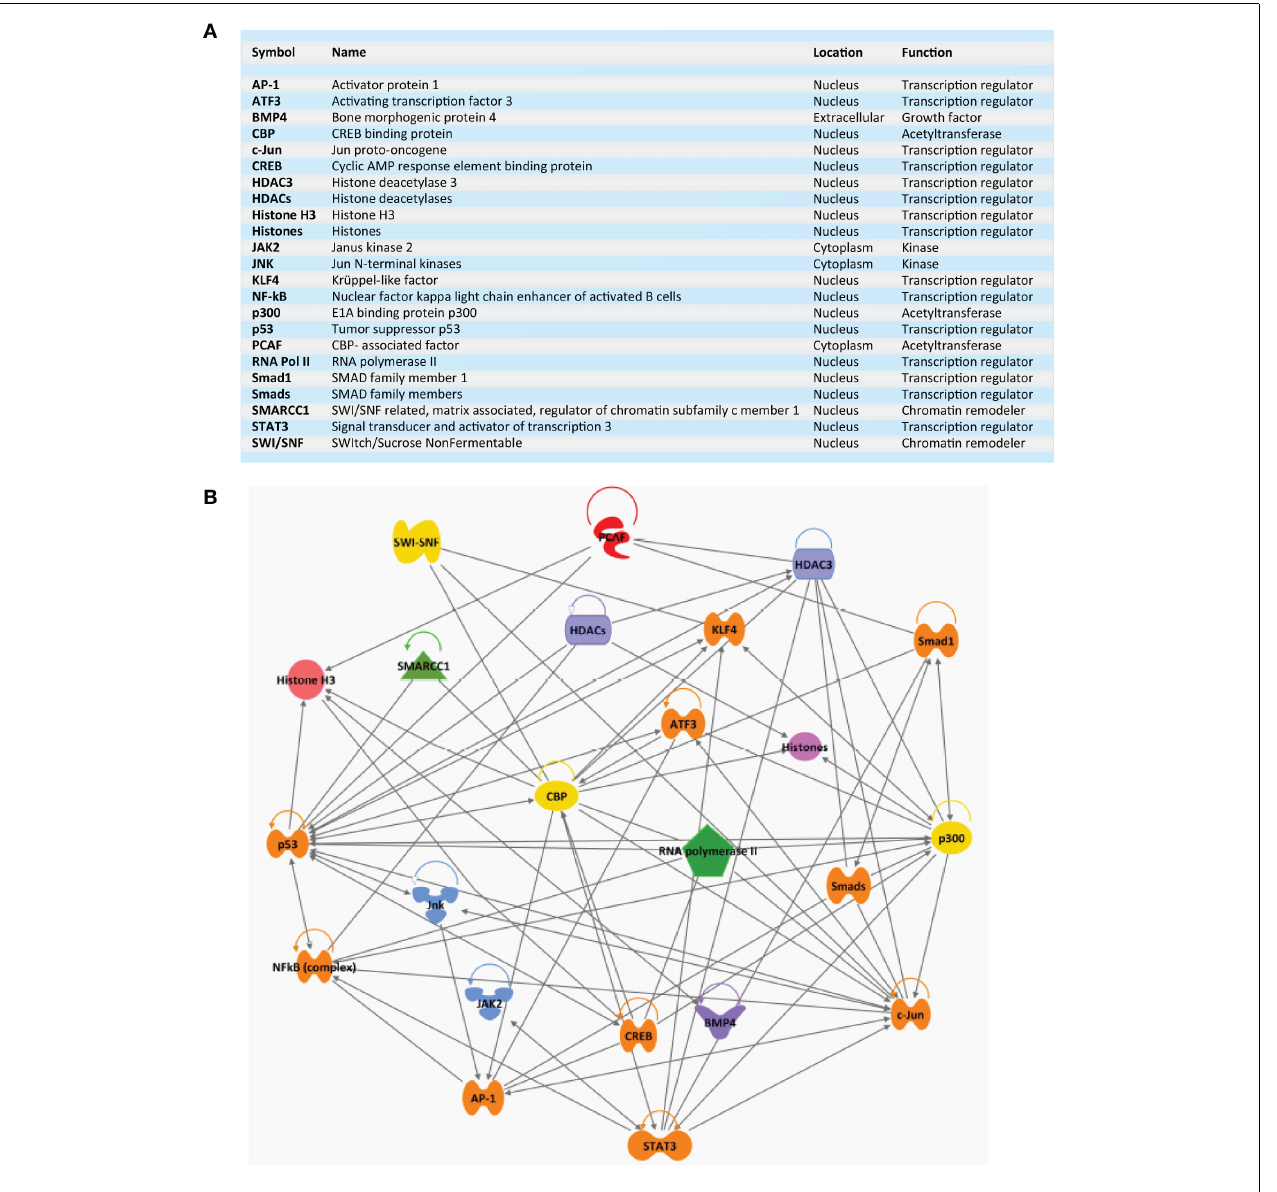
(B) Ingenuity generated screenshot of a regenerative-associated transcriptional network. Connecting arrows and lines represent interactions between